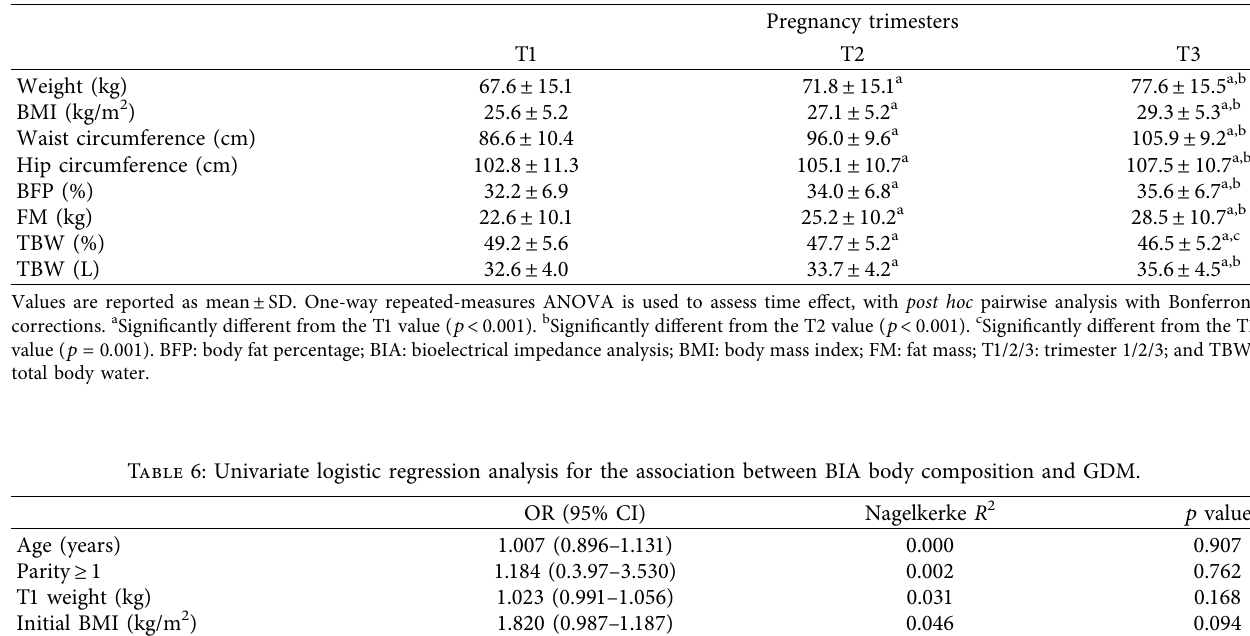
Table 5: Changes in anthropometry and BIA body composition throughout pregnancy ( n �